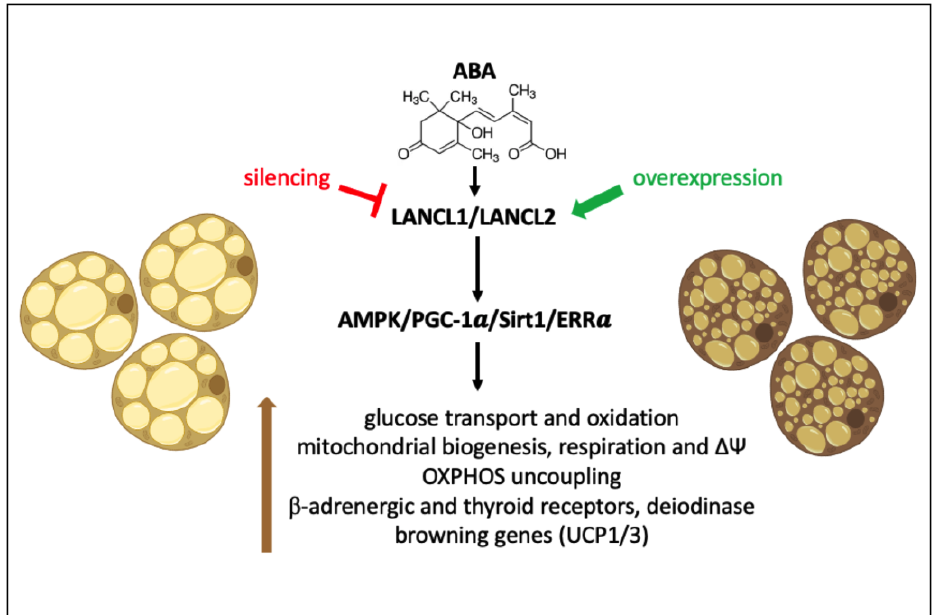
Figure 11. Schematic representation of the role of the ABA/LANCL1/2 hormone/receptor system in the control of energy metabolism, of adipocyte browning and of thermogenesis. Either one of the LANCL proteins can in turn activate the AMPK/PGC-1 α /Sirt1/ERR α pathway, increasing glucose transport and oxidation, mitochondrial biogenesis and respiration, OXPHOS uncoupling and T3 and β -adrenergic receptors. The regulatory pathway was probed by overexpressing or silencing the LANCL